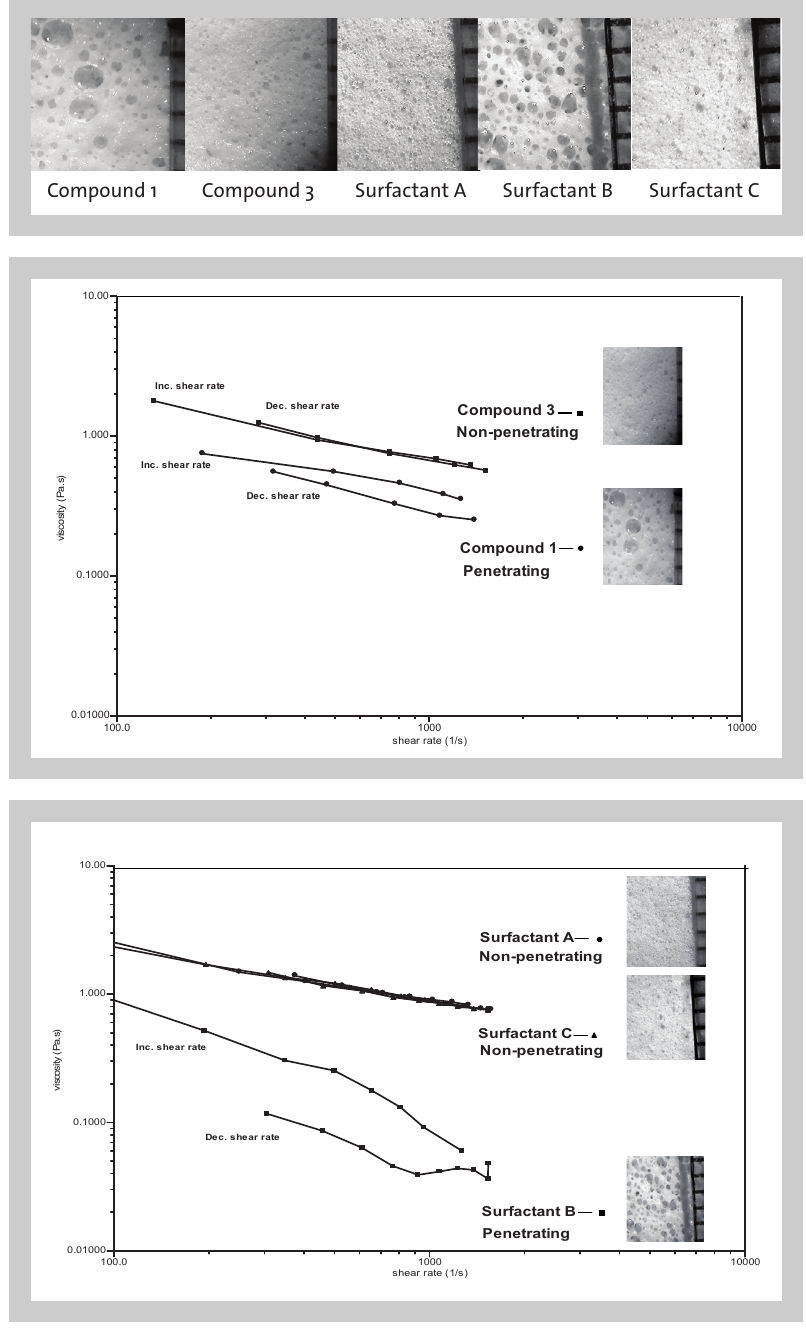
Figure 4 (above): Appearance of bubbles in the Compounds 1 and 3 and with different surfactants. Figure 5 (middle): The viscosity measured with a bob and cup geometry for compounds 1 and 3. Test conducted at 21°C initial froth temperature. Figure 6 (below): The increasing and decreas- ing shear rate rheograms associated with the three compounds A, B, and C. Data for A and C